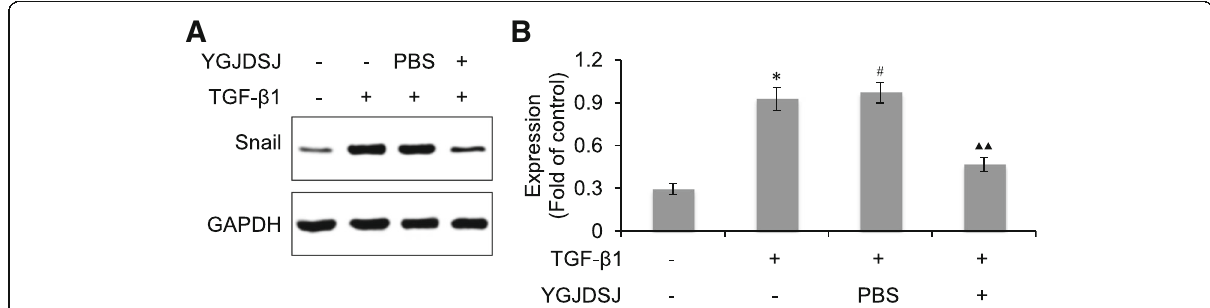
Fig. 4 Effects of YGJDSJ on TGF- β 1-induced Snail expression. a , Bel-7402 cells were treated with TGF- β 1 and YGJDSJ or PBS for 48 h, and subjected to western blotting using indicated antibodies. b , protein expression was quantified by the Quantity One software. * p < 0.01, versus control group; # p > 0.05, versus TGF- β 1 group; ▲▲ p < 0.01, versus PBS